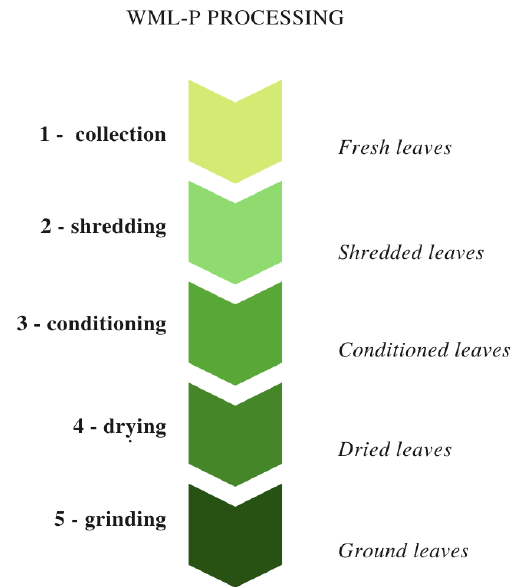
Figure 1. Technological processing of var. zolwinska wielkolistna (WML-P), including controlled conditioning, a novel step in traditional Morus alba leaf processing.